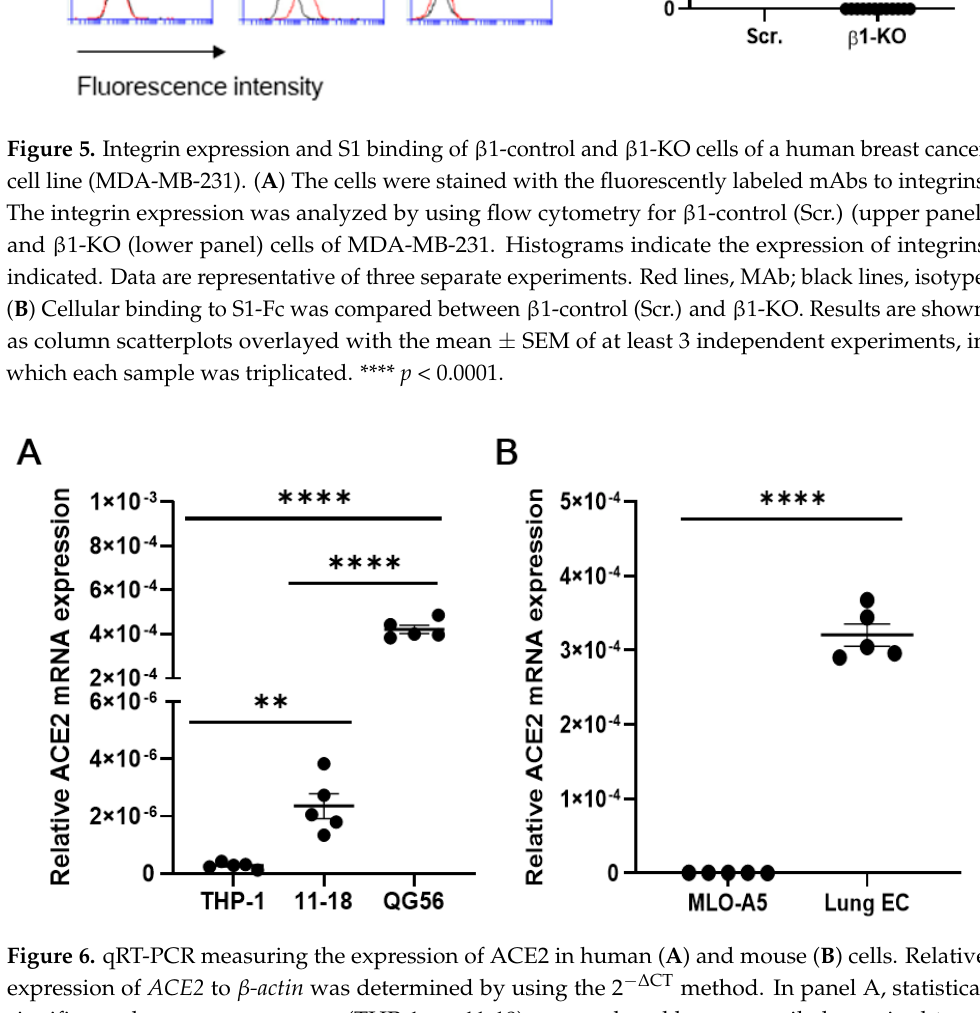
Figure 5. Integrin expression and S1 binding of β 1-control and β 1-KO cells of a human breast can- cer cell line (MDA-MB-231). ( A ) The cells were stained with the fluorescently labeled mAbs to integrins. The integrin expression was analyzed by using flow cytometry for β 1-control (Scr.) (up- per panel) and β 1-KO (lower panel) cells of MDA-MB-231. Histograms indicate the expression of integrins indicated. Data are representative of three separate experiments. Red lines, MAb; black lines, isotype. ( B ) Cellular binding to S1-Fc was compared between β 1-control (Scr.) and β 1-KO. Results are shown as column scatterplots overlayed with the mean ± SEM of at least 3 independent experiments, in which each sample was triplicated. **** p < 0.0001.